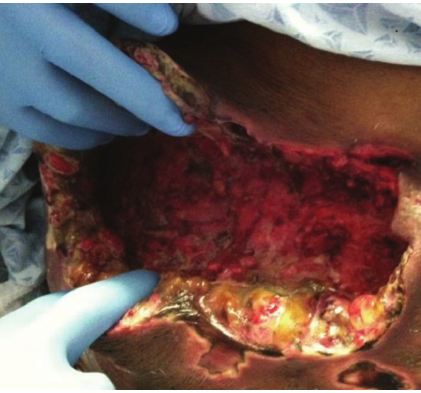
Figure 5: Bedside debridement and pulse lavage of the subcuta- neous collection of the anterior abdominal wall.